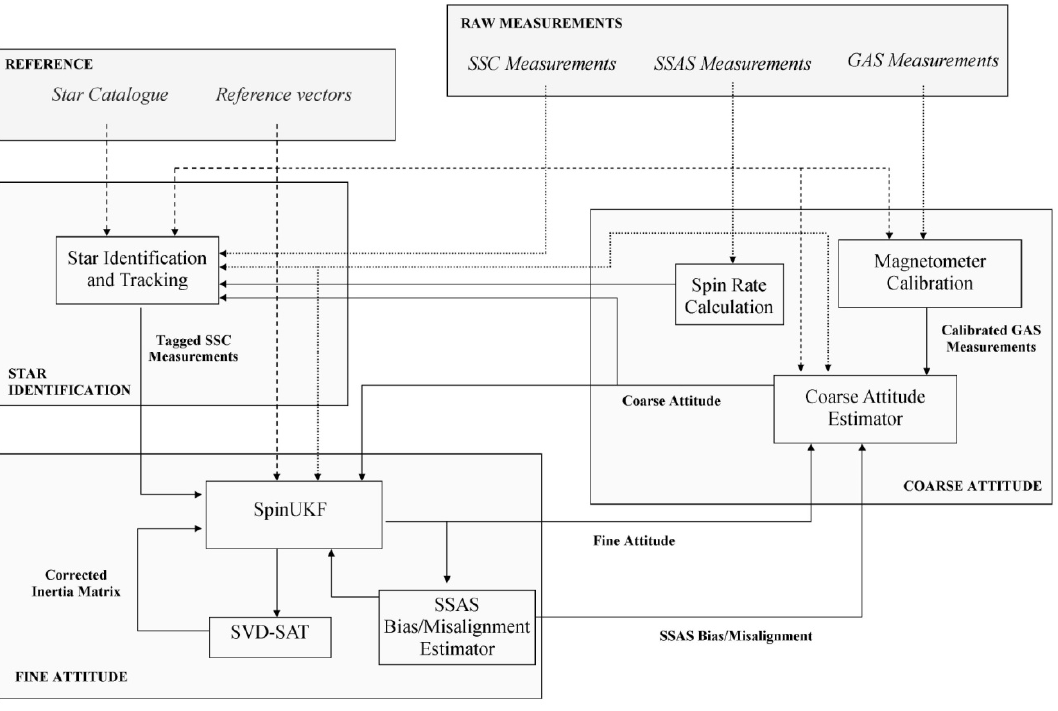
Figure 3. Overview of the filtering-based attitude determination package.